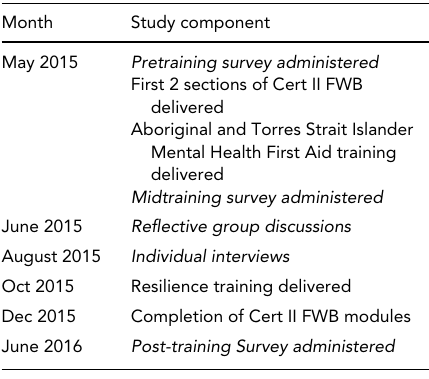
Timeline for Training and Data Collection